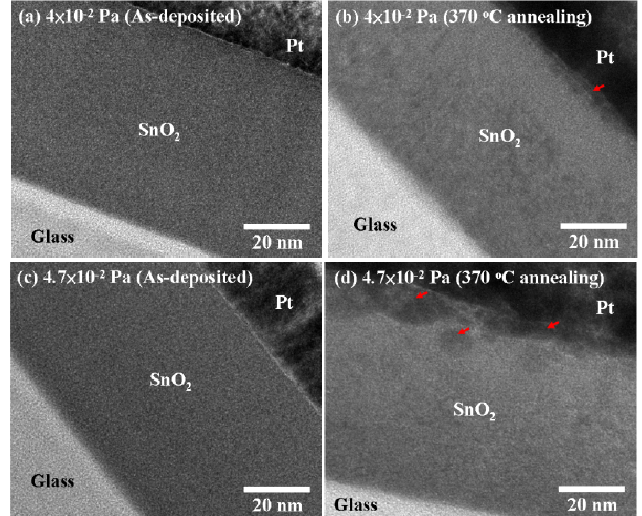
Figure 3. The cross-section images of bright field high-resolution TEM analysis at the same flow ratio of 0.71 of O 2 /(O 2 + Ar) and a working pressure of 4 × 10 − 2 Pa ( a ) for as-deposited films; ( b ) 370 °C annealing and a working pressure of 4.7 × 10 − 2 Pa ( c ) for as-deposited films; ( d ) 370 °C annealing.